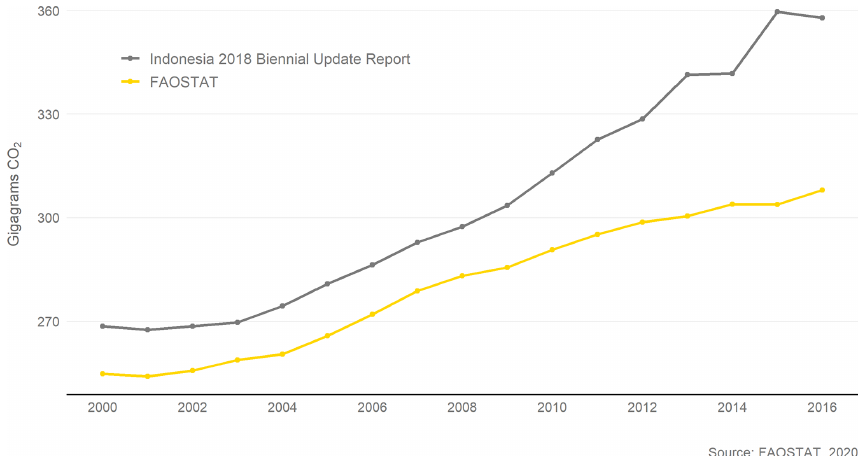
Figure 13. FAOSTAT estimates vs. reported CO 2 emissions from the drainage of organic soils in Indonesia, 1990–2016 (Second Biennial Update Report, 2018 submission to the Climate